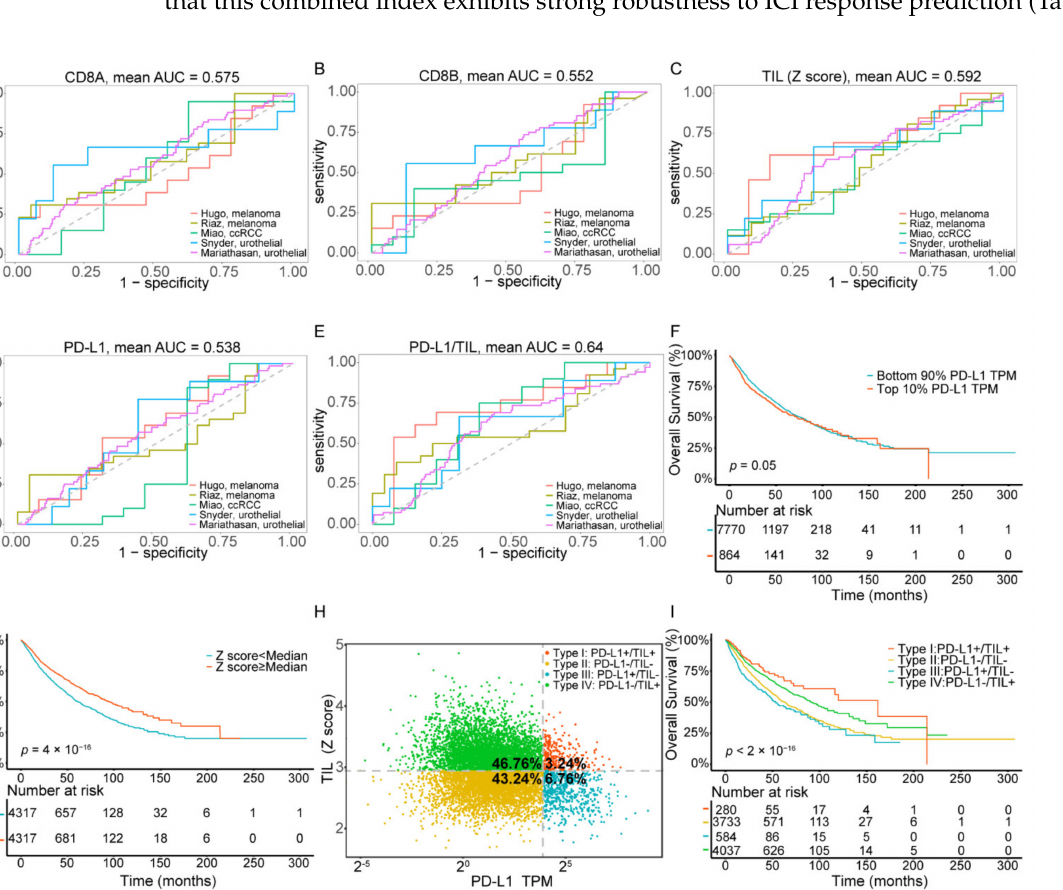
Figure 1. Combination of the TIL Z score and PD-L1 predicts clinical response to ICI immunotherapy and the stratification of four TIME subtypes across pan-cancer types. ( A – E ) ROC curves for the performance of CD8A, CD8B, the TIL Z score, PD-L1, and the combined TIL Z score with PD-L1 for predicting anti-PD-1 immunotherapy response in patients who received ICI therapy. ( F ) Kaplan–Meier survival curves of patients based on PD-L1 expression. ( G ) Kaplan–Meier survival curves of patients based on the TIL score. ( H ), The proportions of patients in type I, type II, type III, and type IV. ( I ) Kaplan–Meier survival curves of patients in type I, type II, type III, and type IV. Abbreviations: TIL: tumor-infiltrating lymphocyte, ICI: immune checkpoint inhibitors, TIME: tumor immune